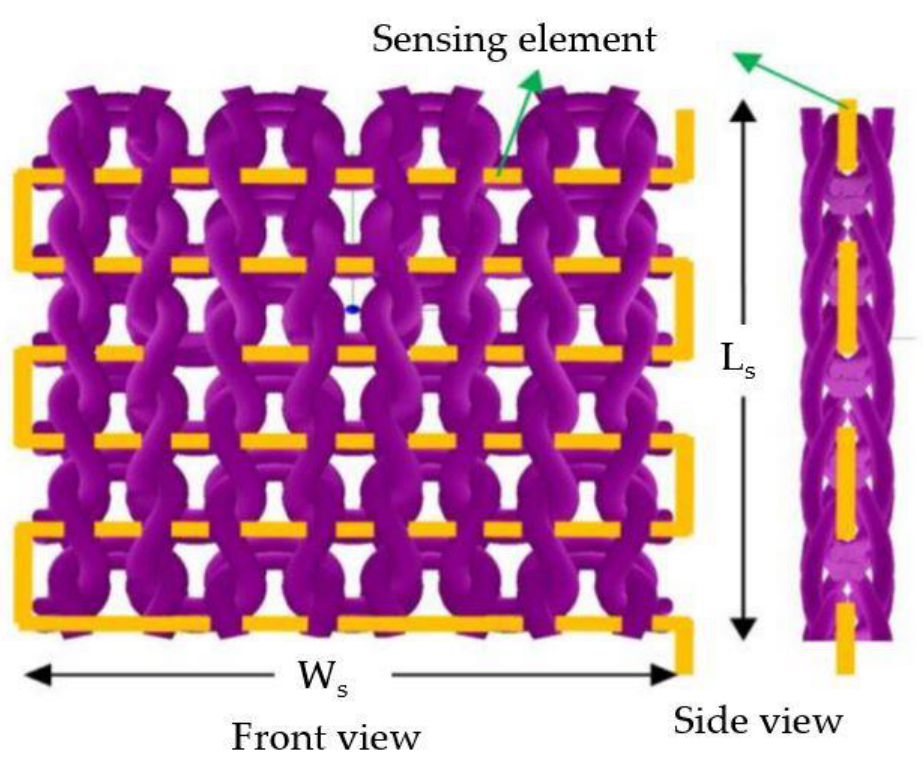
Figure 4. A textile temperature sensor, metal rods are intertwined with the fabric, reprinted with permission from [39].